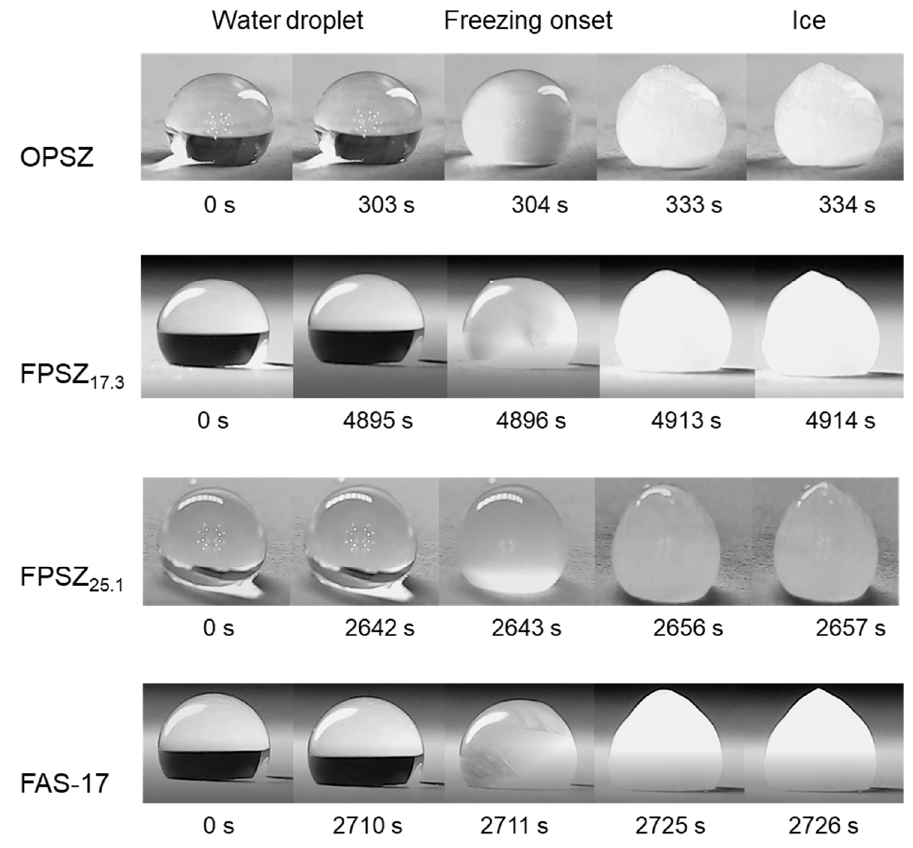
Figure 6. Optical images of 10 μ L water droplets on coated Al surfaces. The surface energy of the R f groups of FPSZs is lower than that of the CH 3 –Si groups of OPSZ and the R f chains arrange densely at the solid–air interface above a certain R f content [36,37]. The thickness of the coating layer increased at the molecular level because of the surface orientation of the R f groups. The XPS data in Table 2 indicate the surface- covering effect caused by the orientation of the R f groups after FPSZ coating. XPS analysis can be used to identify the atoms present in a 10 nm thick layer beneath the surface. Our results indicated that the amount of Al in the substrate decreased as the thickness of the coating layer increased. The XPS-determined Al contents of the OPSZ- and FPSZ 17.3 -coated Al samples were 16.8% and 1.4%, respectively. By contrast, the Al content of the FAS-17- coated Al sample was 27.6%, indicating that the FPSZ 17.3 coating layer was thicker than the OPSZ and FAS-17 coating monolayers. In addition, as the R f content of the FPSZ layer increased, the Al 2p values were decreased until the R f reached 17.3 and were then increased at contents higher than 17.3. The coating layers of FPSZs with high R f contents (>17.3) were relatively non-uniform compared to that of FPSZ 17.3 , and non-uniformity was closely related to the rapid increase in ice adhesion